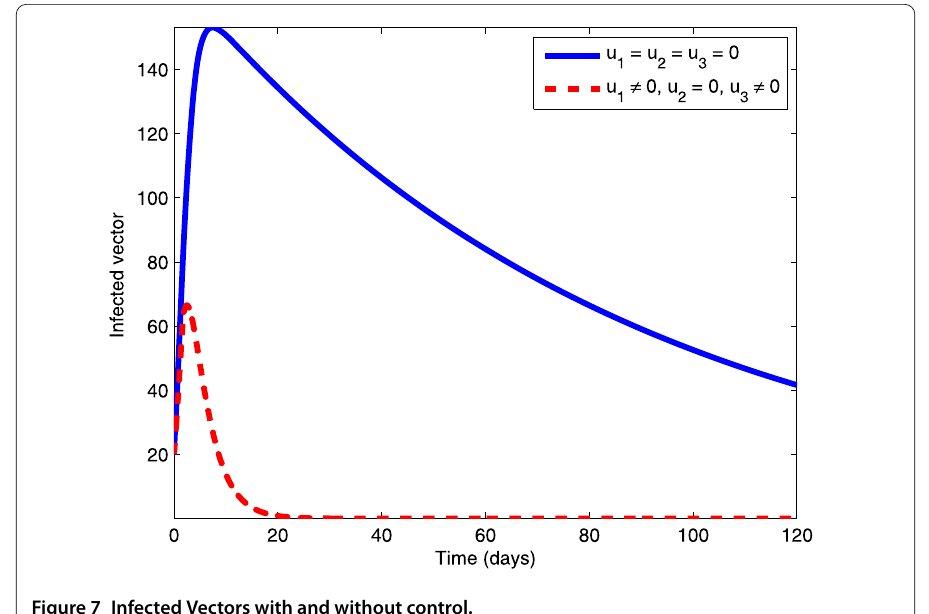
Figure 7 Infected Vectors with and without